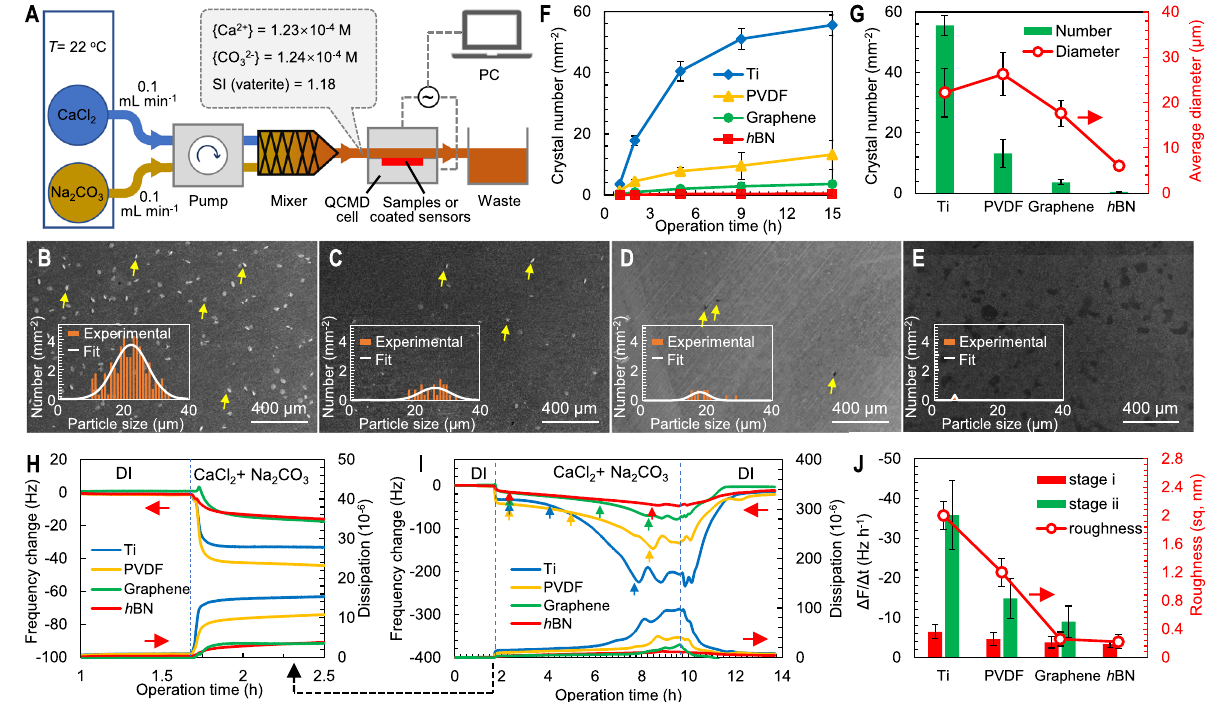
Fig. 2 | Characterization of surface-induced heterogeneous nucleation of CaCO 3 on Ti, PVDF, graphene, and h BN. A A schematic of QCMD experimental setup for characterizing CaCO 3 heterogeneous nucleation on four surfaces. SI: saturation index, PC: personal computer, QCMD: quartz crystal microbalance with dissipation;SEMimagesofCaCO 3 crystalsformedon B Ti, C PVDF, D graphene,and E h BN coatings on Cu substrate after 9h of operation, with insets showing the size distribution of vaterite crystals formed. The particle size distribution shown in the B – E inserts are obtained using the ImageJ software and fi tted with a Gaussian distribution function; Average number and size of vaterite crystals grown on the